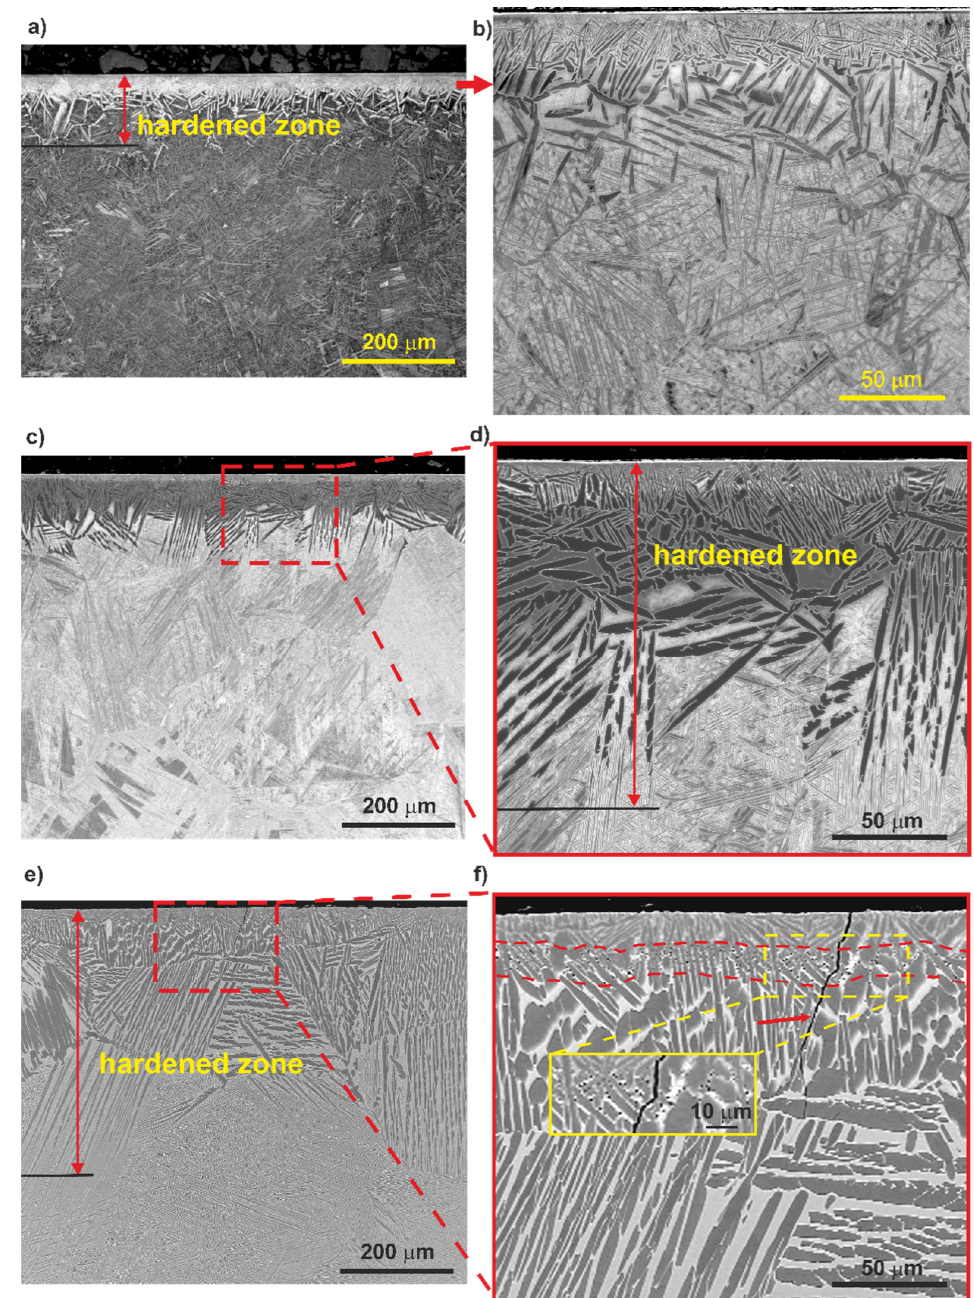
Figure 3. Microstructure of the Ti–13Nb–13Zr alloy after oxygen hardening at 700 °C ( a , b ), 850 °C ( c , d ) and 1000 °C ( e , f ). LM ( a ) and SEM ( b – f ), cross-section samples. The zone with voids is marked with a dashed line in Figure 3f. An arrow in Figure 3f indicates a microcrack developed in the near-surface zone.